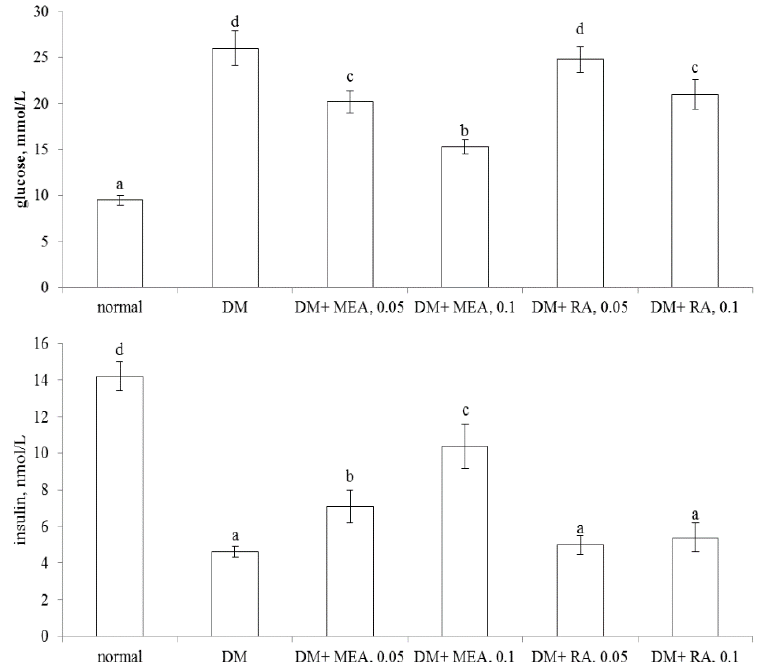
Figure 2. Plasma levels of glucose (mmol/L, upper part) and insulin (nmol/L, lower part) of normal (non-diabetic), diabetic mice consumed normal diet (DM), or 0.05%, 0.1% MEA or RA for six weeks. Data are mean ± SD, n = 10. a–d Means among bars without a common letter differ, p < 0.05. Table 2. Coagulatory factors, PAI-1 activity (kU/L) and fibrinogen level (g/L); anti-coagulatory factors, AT-III activity (%) and protein C activity (%) in plasma from normal (non-diabetic), diabetic mice consumed normal diet (DM), or 0.05%, 0.1% MEA or RA for 6 wks. Data are mean ˘ SD, n = 10. DM + MEA, Normal DM